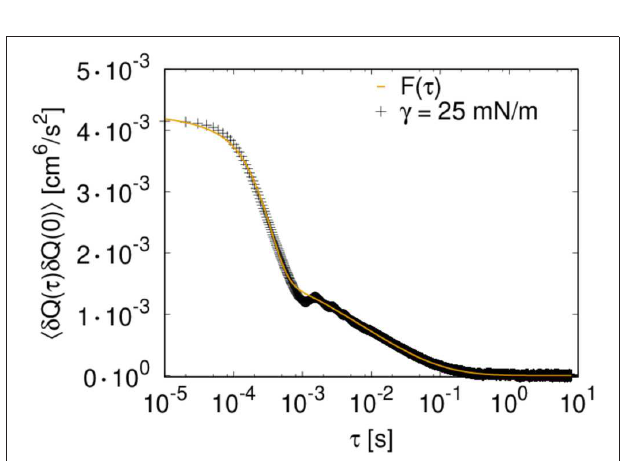
FIGURE 7 | Fit of function F(t) (Equation 9) to the autocorrelation function of the total volume flow for case (A) with γ = 25 mN/m ( 1 P /1 x = 100 kPa/m and 30 × 20 links).